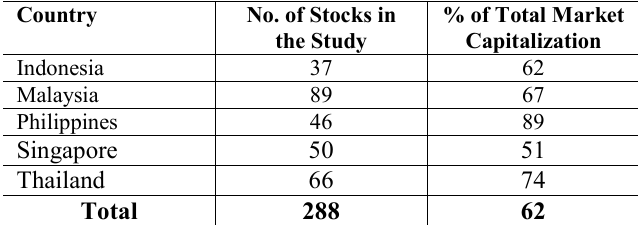
Table 1: Benchmark coverage snapshot